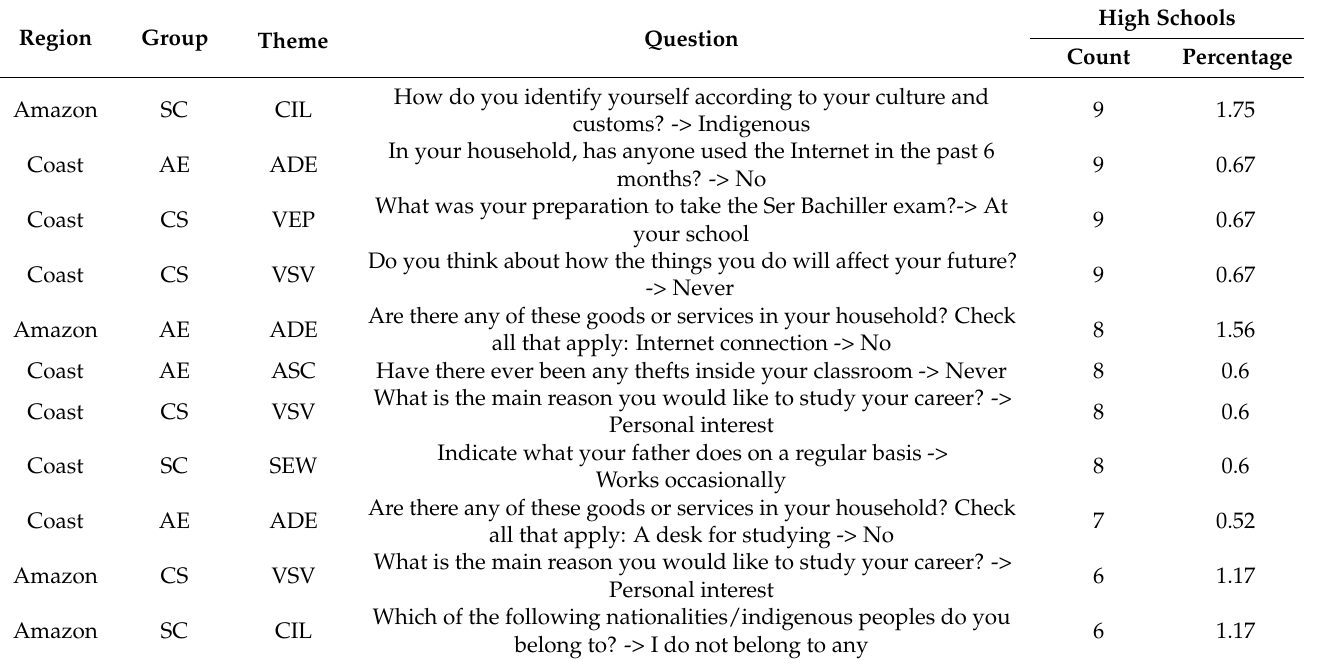
Table A2. Best predictive questions and answers for the low AP classification, according to groups, themes, and regions. The questions are sorted by their respective